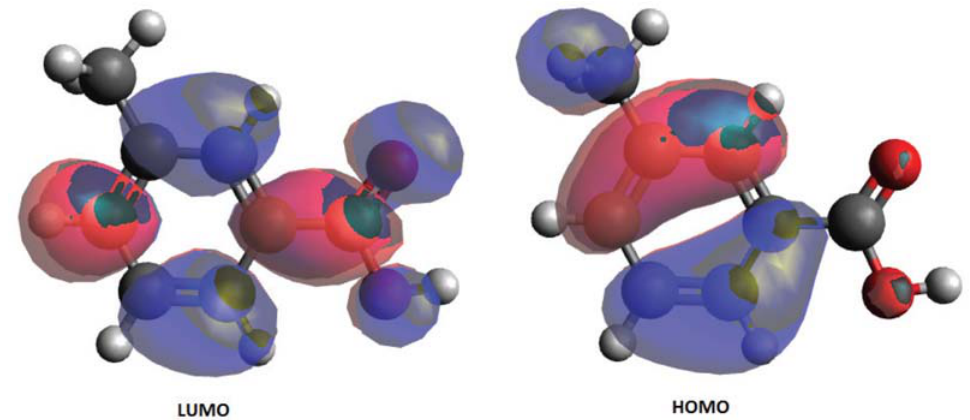
Figure 4. The atomic orbitals composition of the frontier molecular orbital for m -toluic